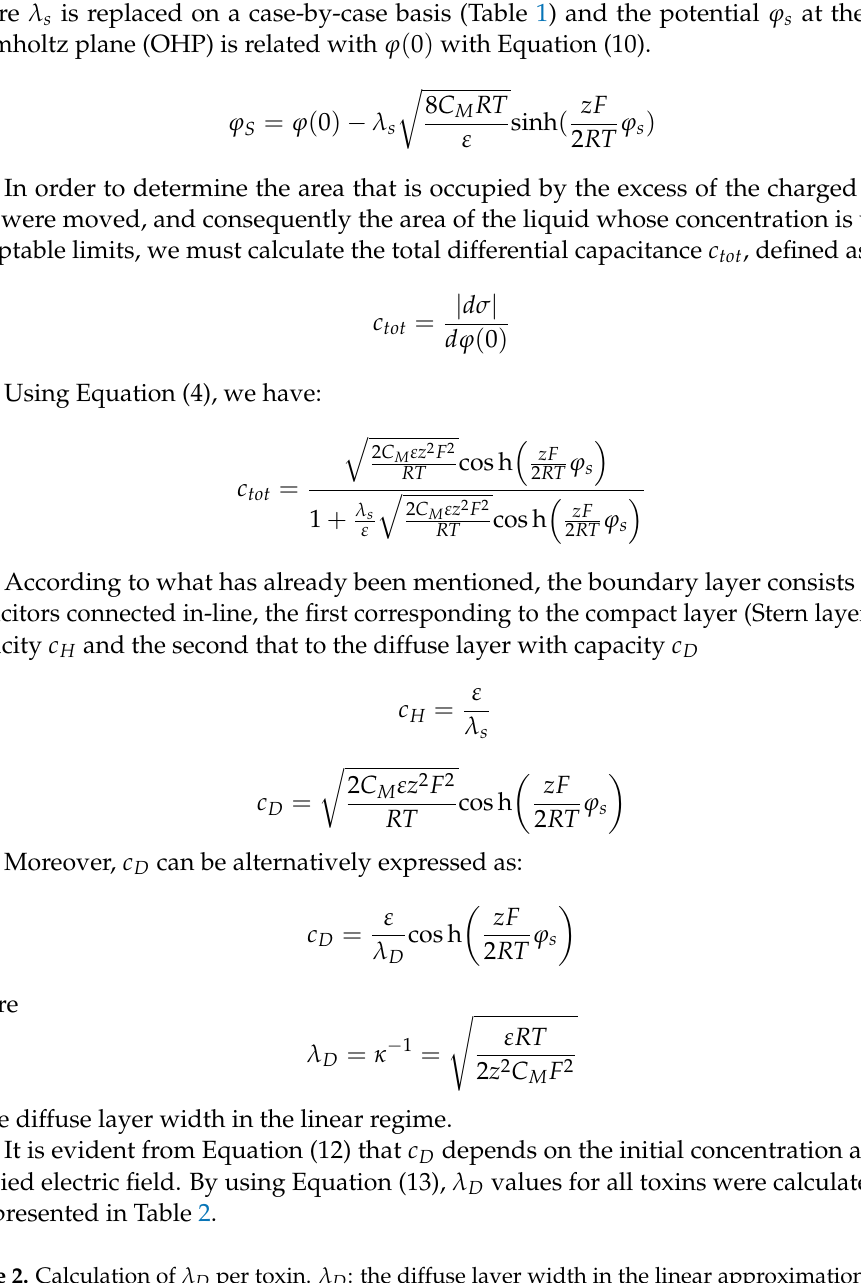
Table 2. Calculation of λ D per toxin. λ D : the diffuse layer width in the linear approximation which applies only when the applied potential is very small (it is a characteristic constant). C M : the toxin concentration at the middle of the duct after the electric potential